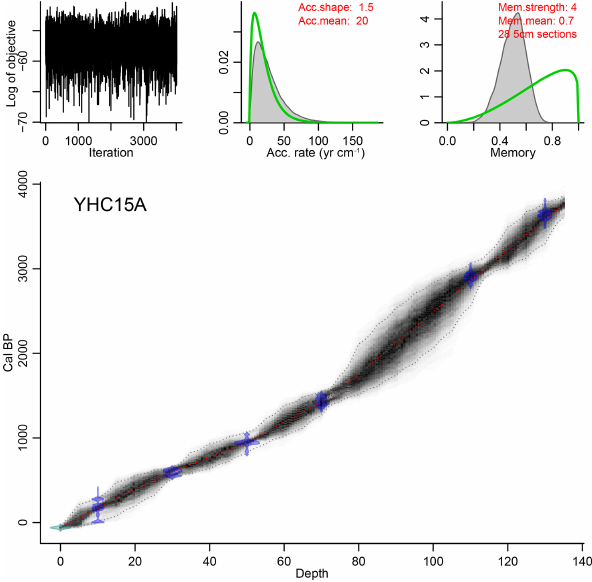
Figure 2. The age model determined on five radiocarbon dates of organic bulk sediments from core YHC15A. The age–depth model was developed with a smooth fitting using CLAM 2.2 (Blaauw,